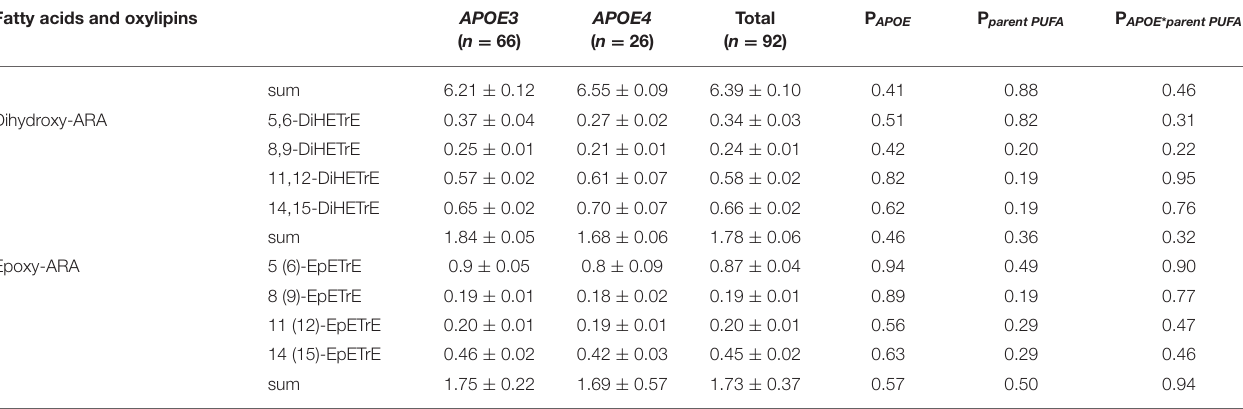
HEPE, 9-HEPE, 11-HEPE, and 20-HEPE was observed at a